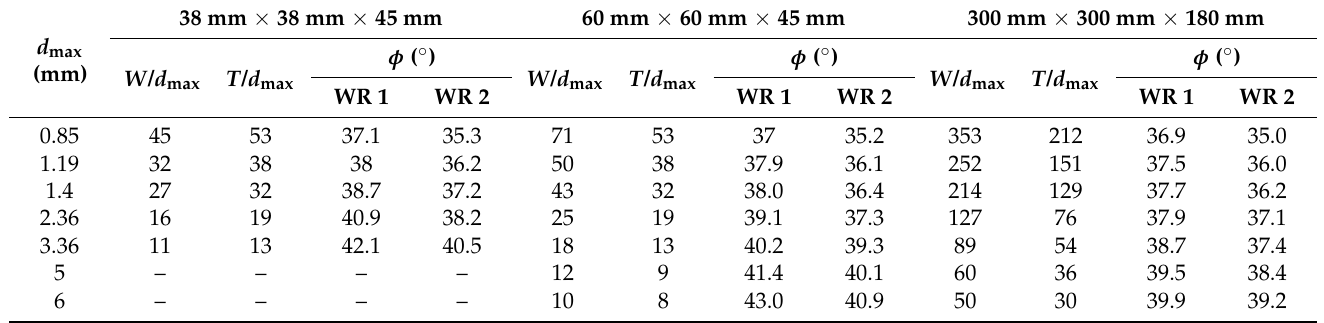
Table 11. Friction angles of the specimens obtained by extra small, small, and large shear boxes for WR 1 and WR 2.